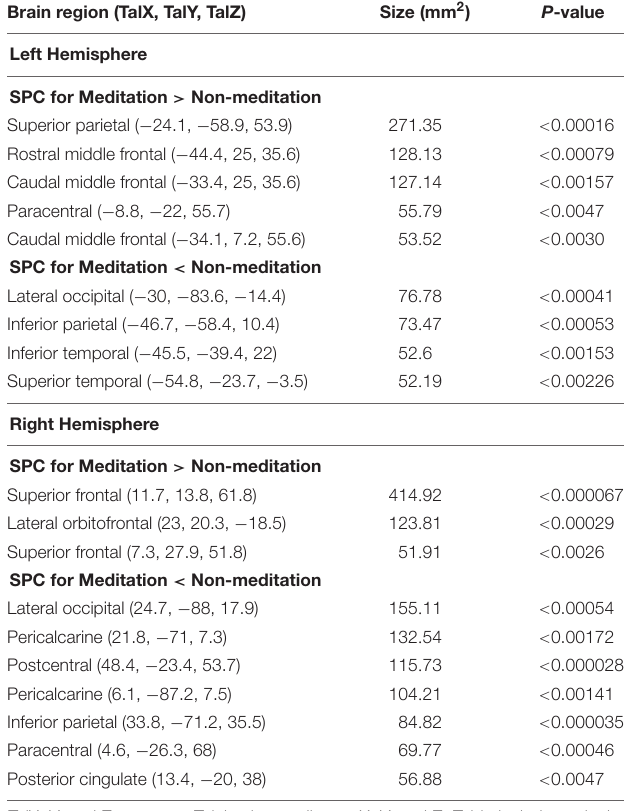
TABLE 5 | Brain regions showing significant cortical thickness SPC changes (increase/decrease) in voxel-based analysis between the meditation and non-meditation groups corrected for multiple comparisons, age, gender, and education in both hemispheres. Brain region (TalX, TalY,